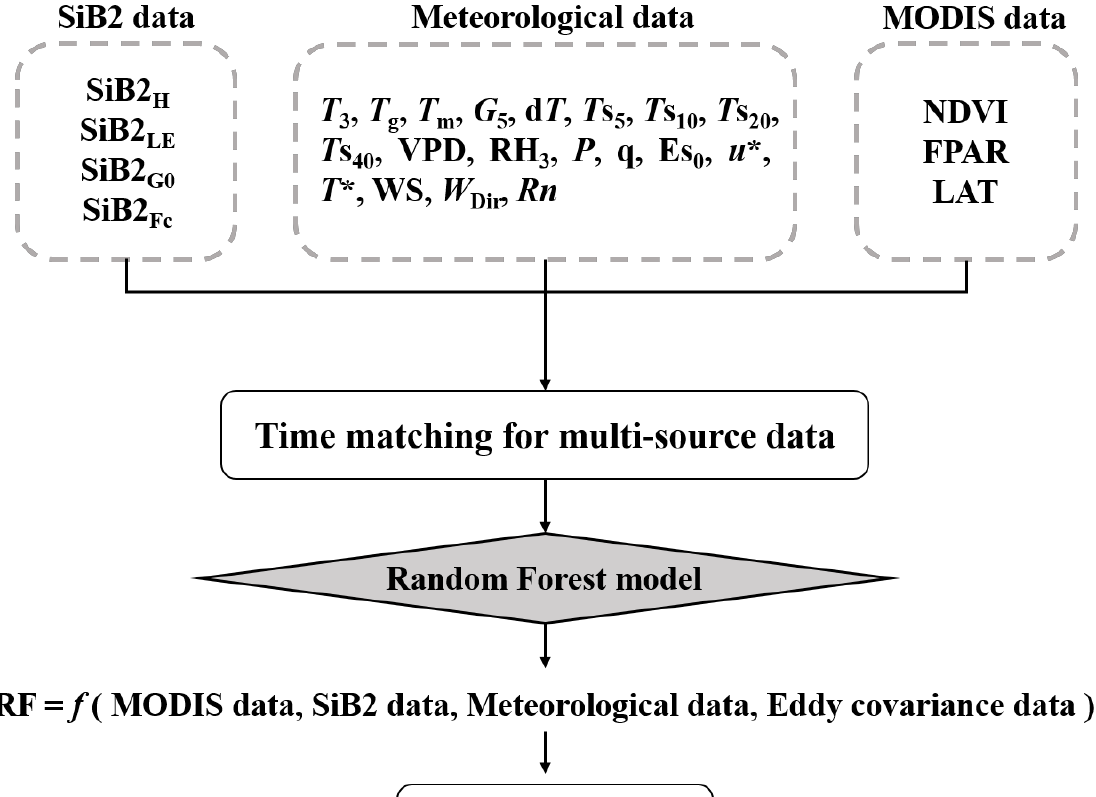
Figure 3. Flowchart of the RF model’s three-stage correction of the SiB2 model outputs.